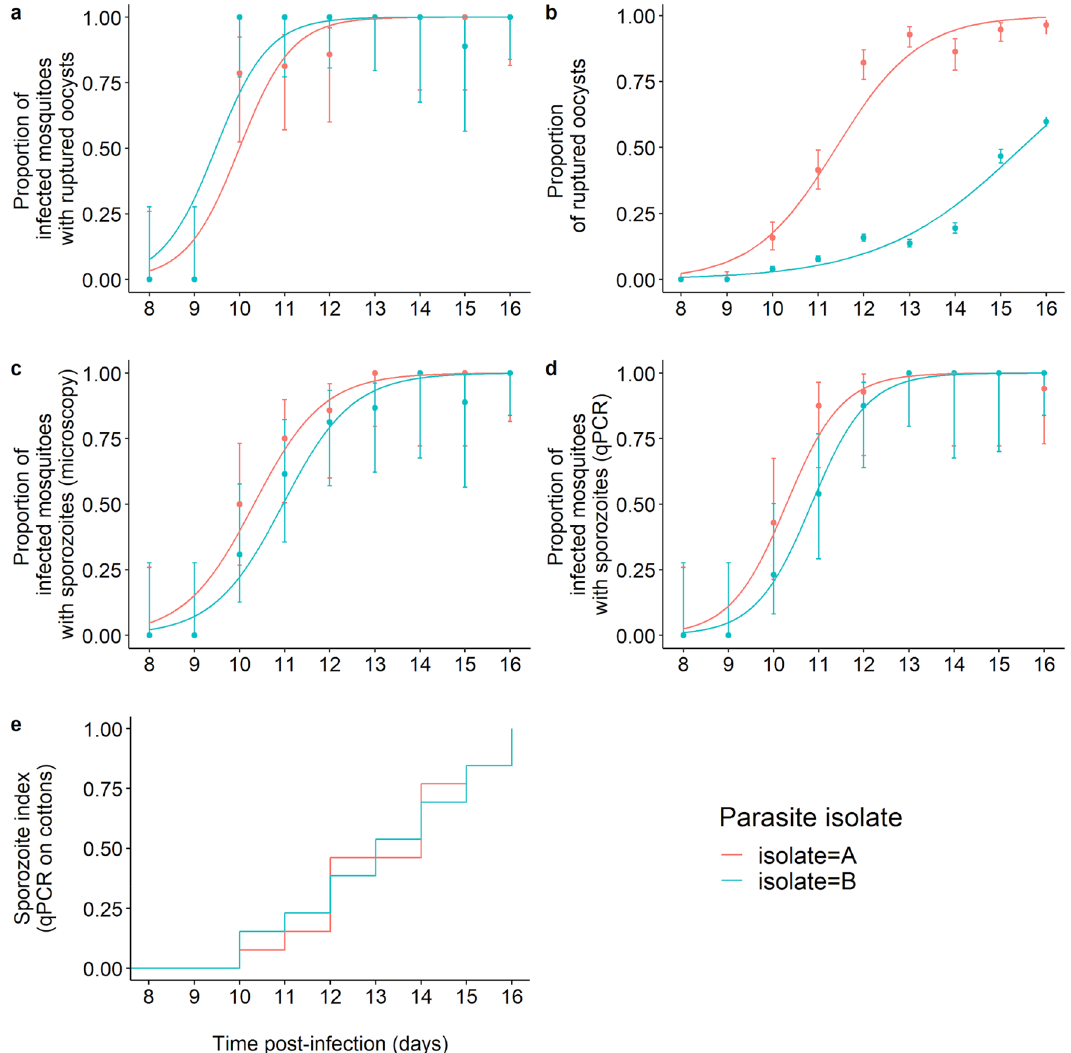
Figure 1. The extrinsic incubation period of Plasmodium falciparum estimated using classical dissection approaches ( a – d ) and a novel non-destructive assay ( e ). ( a ) Proportion of infected mosquitoes with ruptured oocysts (± 95% CI) from 8 to 16 dpbm, expressed as the number of mosquitoes with at least one ruptured oocyst out of the total number of infected mosquitoes (i.e. harboring either intact and/or ruptured oocysts) for two parasite isolates. The lines represent best-fit logistic growth curves for each isolate. ( b ) Proportion of ruptured oocysts (± 95% CI), expressed as the number of ruptured oocysts out of the total number of oocysts (intact + ruptured). The lines represent best-fit logistic growth curves for each isolate. ( c ) Proportion of oocyst- infected mosquitoes with microscope-identified sporozoites in the salivary glands (± 95% CI), expressed as the number of oocyst-infected mosquitoes harboring sporozoites in their salivary glands out of the total number of infected mosquitoes. The lines represent best-fit logistic growth curves for each isolate. ( d ) Same as ( c ) but the presence of sporozoites was detected using qPCR. ( a – d ) Sample size = 8 to 20 midguts /day/isolate (median = 14). ( e ) Kaplan–Meier curves representing the temporal dynamics of sporozoites appearance in small pieces of cotton used to collect saliva from individual